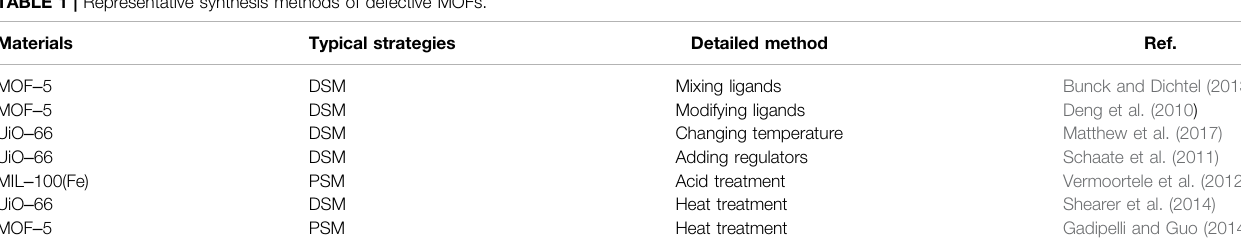
TABLE 1 | Representative synthesis methods of defective